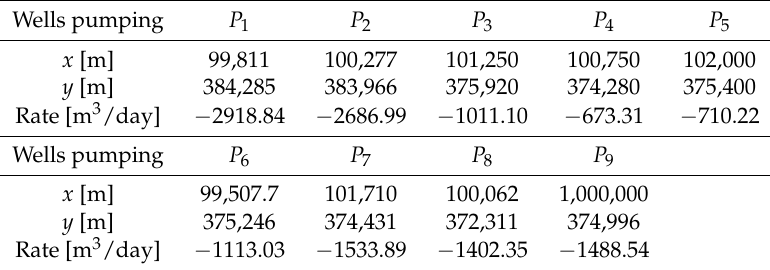
Table 4. Well position and rate